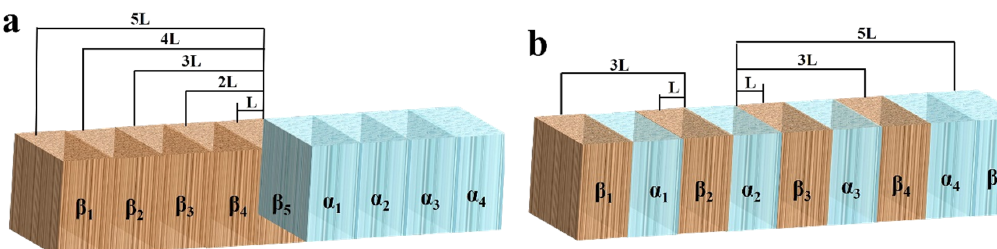
Figure 13. Diagrams of the model depicting the influence of the refined second phase on the microgalvanic corrosion of ( a ) Ex-AZ91-free alloy and ( b ) Ex-AZ91-Y alloy. On the basis of the model (Figure 13), if I 1 , I 2 , I 3 …… I 7 , I 8 are defined as the average galvanic current densities between the α phase and the second phase with the distances of L , 2 L , 3 L …… 7 L ,